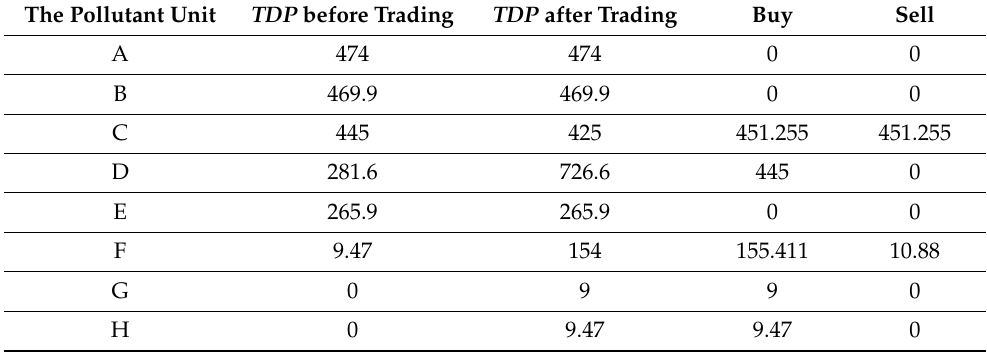
Table 4. Pollutant discharge